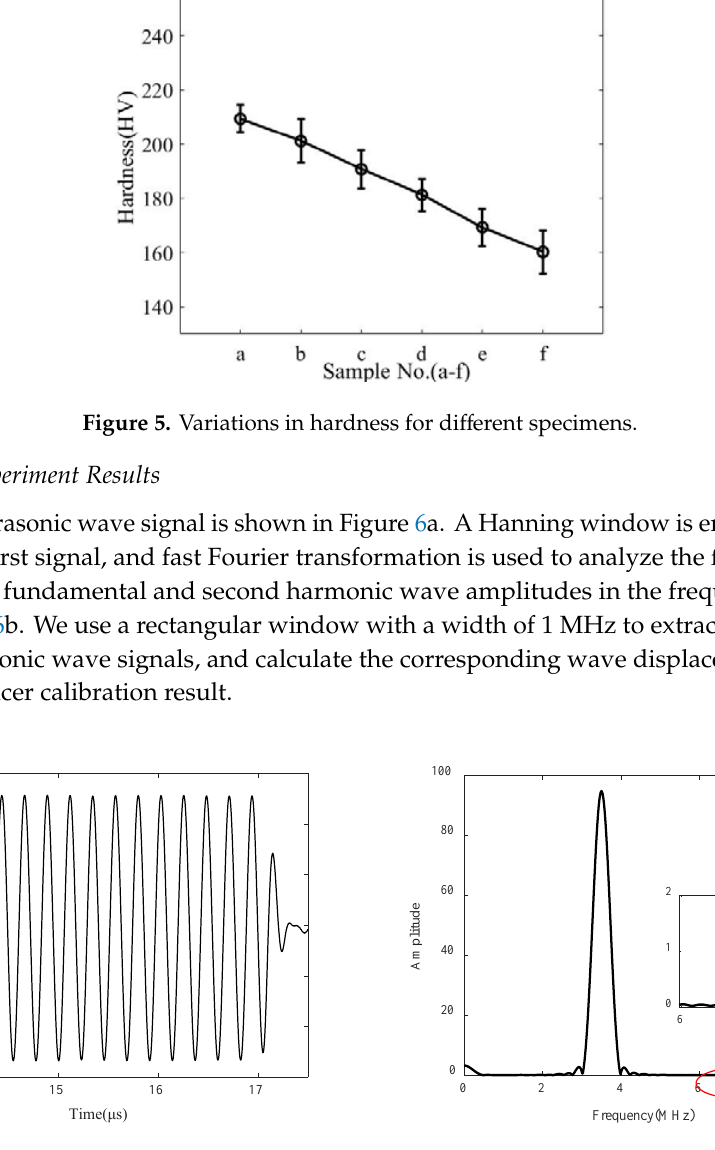
Figure 7. The slopes of A 2 /A 12 for different specimens. Table 3. Nonlinear parameters for different specimens before and after corrections.